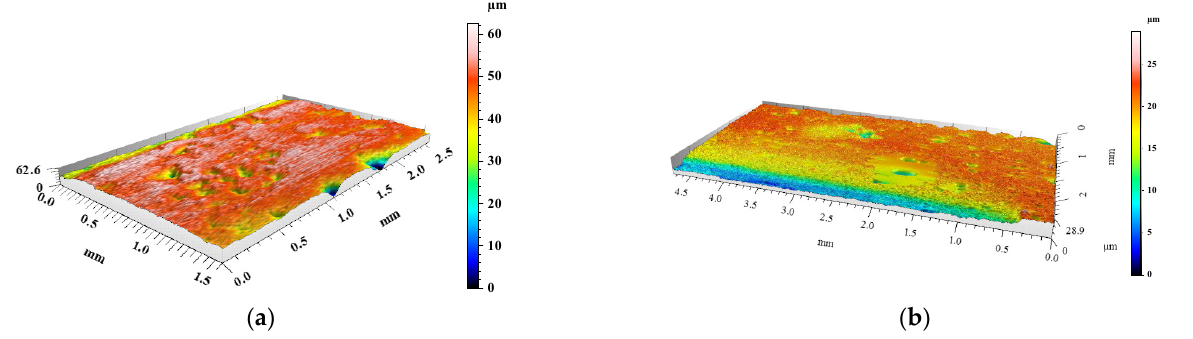
Figure 12. View of AlSi12/SiC p + GC p hybrid composite surface geometry: ( a ) before and ( b ) after dry friction test.